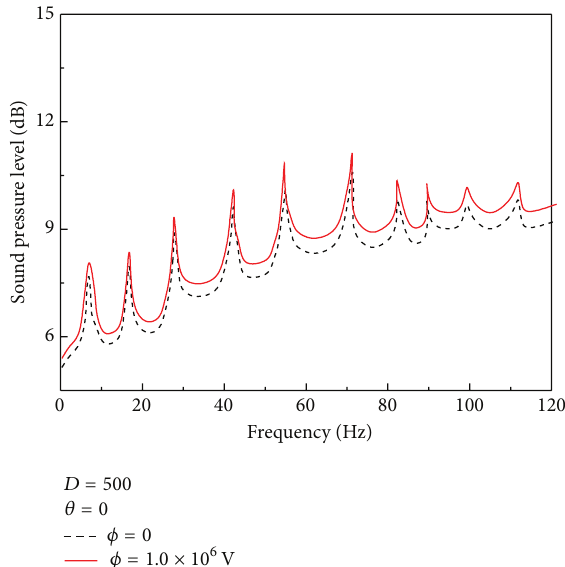
Figure 17: Acoustic pressure of the underwater structure when a positive electric potential is applied.